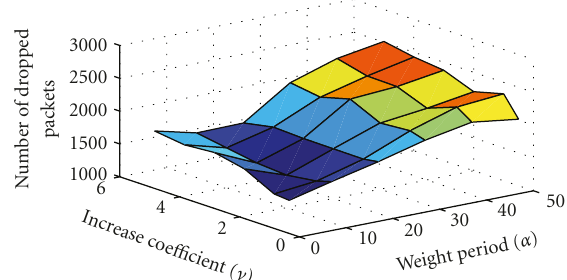
Figure 2: The e ff ects of UBS-related parameters on the overall performance of the network, in terms of number of dropped packets.